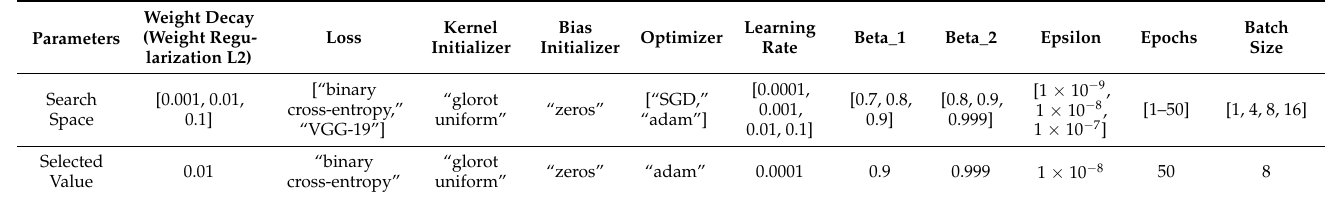
Figure 8. Training loss, validation loss, and validation accuracy curves of PI-GAN and PI-CNN with Fruits-360 dataset. ( a , b ) training loss and validation loss curves, respectively, of PI-GAN; ( c , d ) show the training and validation loss and accuracy curves of the proposed PI-CNN, respectively. Table 12. Search space and selected values of hyperparameters for PI-GAN.